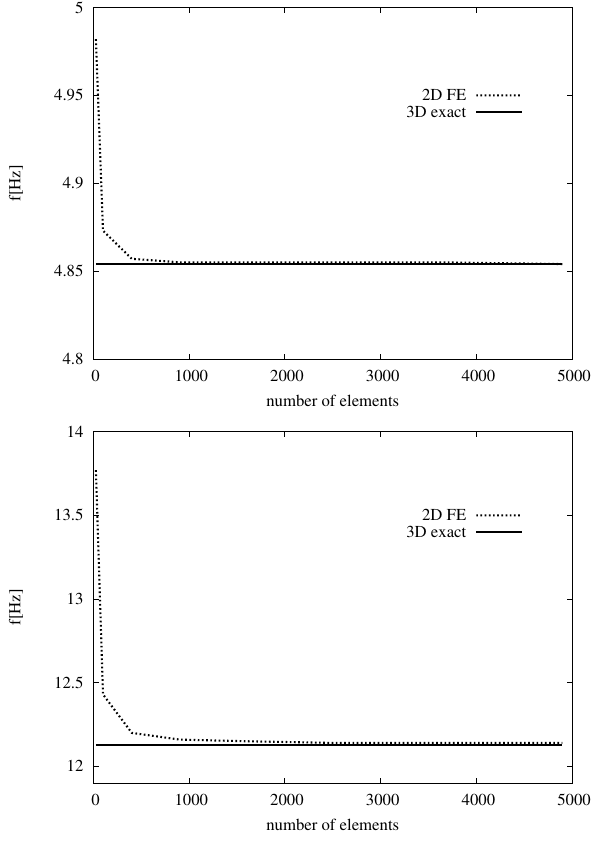
Figure 4: First assessment for the 2D FE solution, simply supported plate made of aluminium alloy with thickness ratio a/h=1000. Fre- quency f[Hz] vs. number of elements for the mode (1,1) (at the top) and for the mode (1,2) (at the